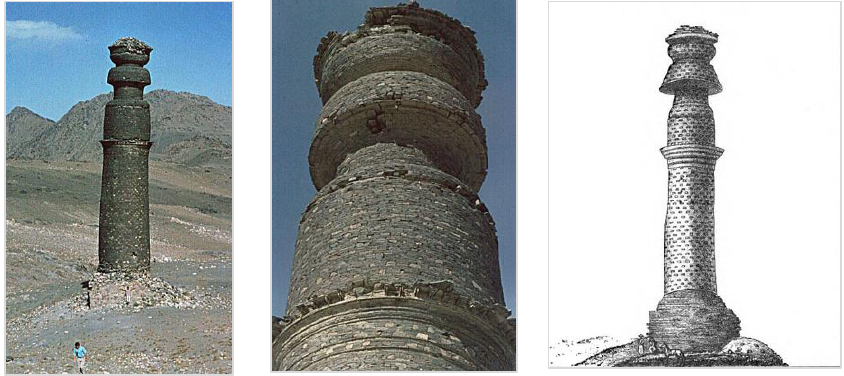
Figure 3 Minaret of Chakari (Buddhist pillar) in Kabul city (Dorn’eich, 1999)